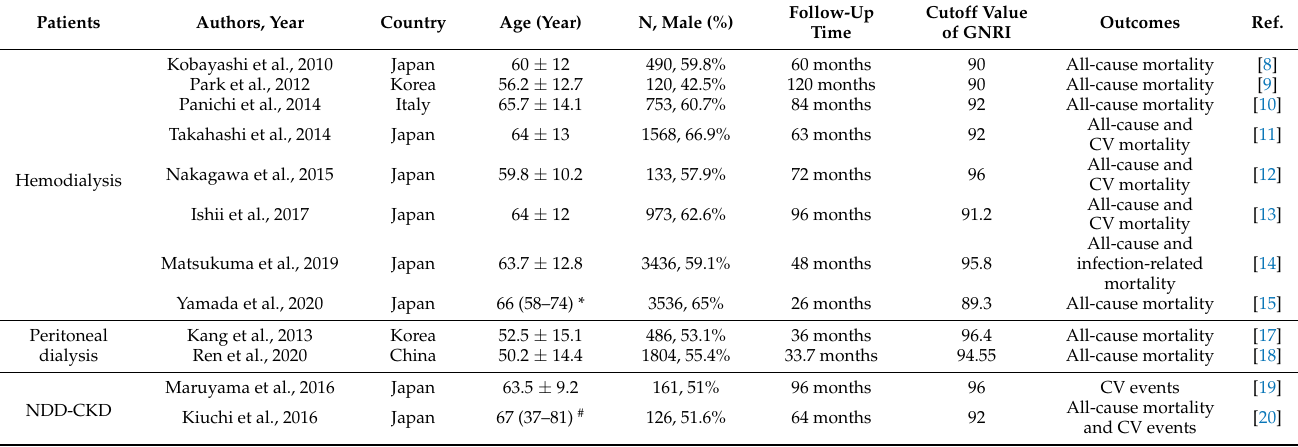
Table 1. Summary of cohort studies investigating the relationship of GNRI with outcomes in patients with